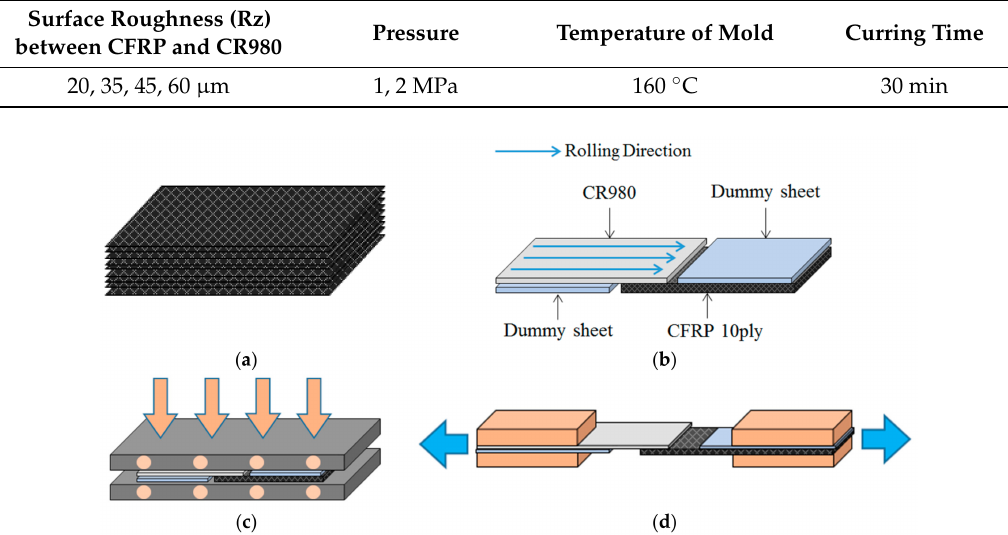
Figure 2. A method of making test specimens for bonding strength measurements, and a schematic diagram of shear testing: ( a ) CFRP 10-ply; ( b ) CFRP/CR980 and dummy sheet laminating; ( c ) hot compression molding; ( d ) shear lap adhesion test.